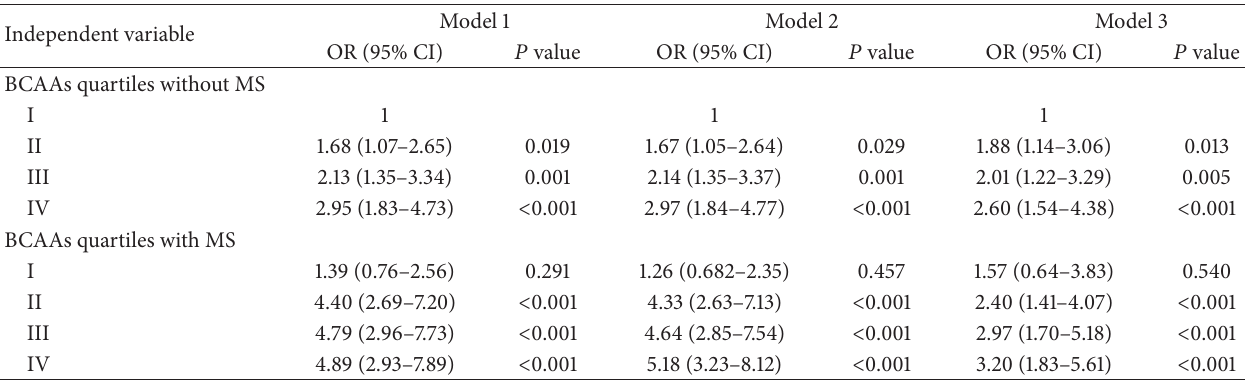
Table 5: Multiple logistic regression analyses of the relationship between BCAAs quartiles without or with MS and high Framingham cardiovascular